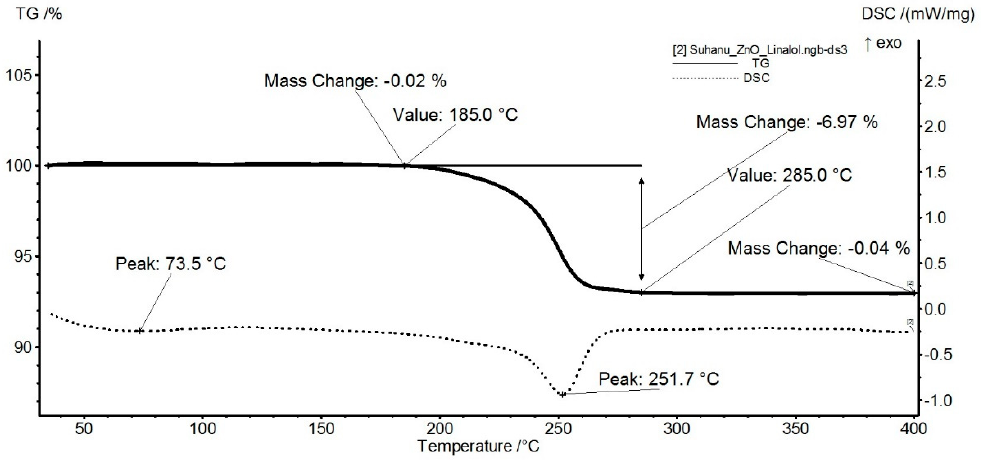
Figure 5. Thermogravimetric analysis of ZnO@LiN.